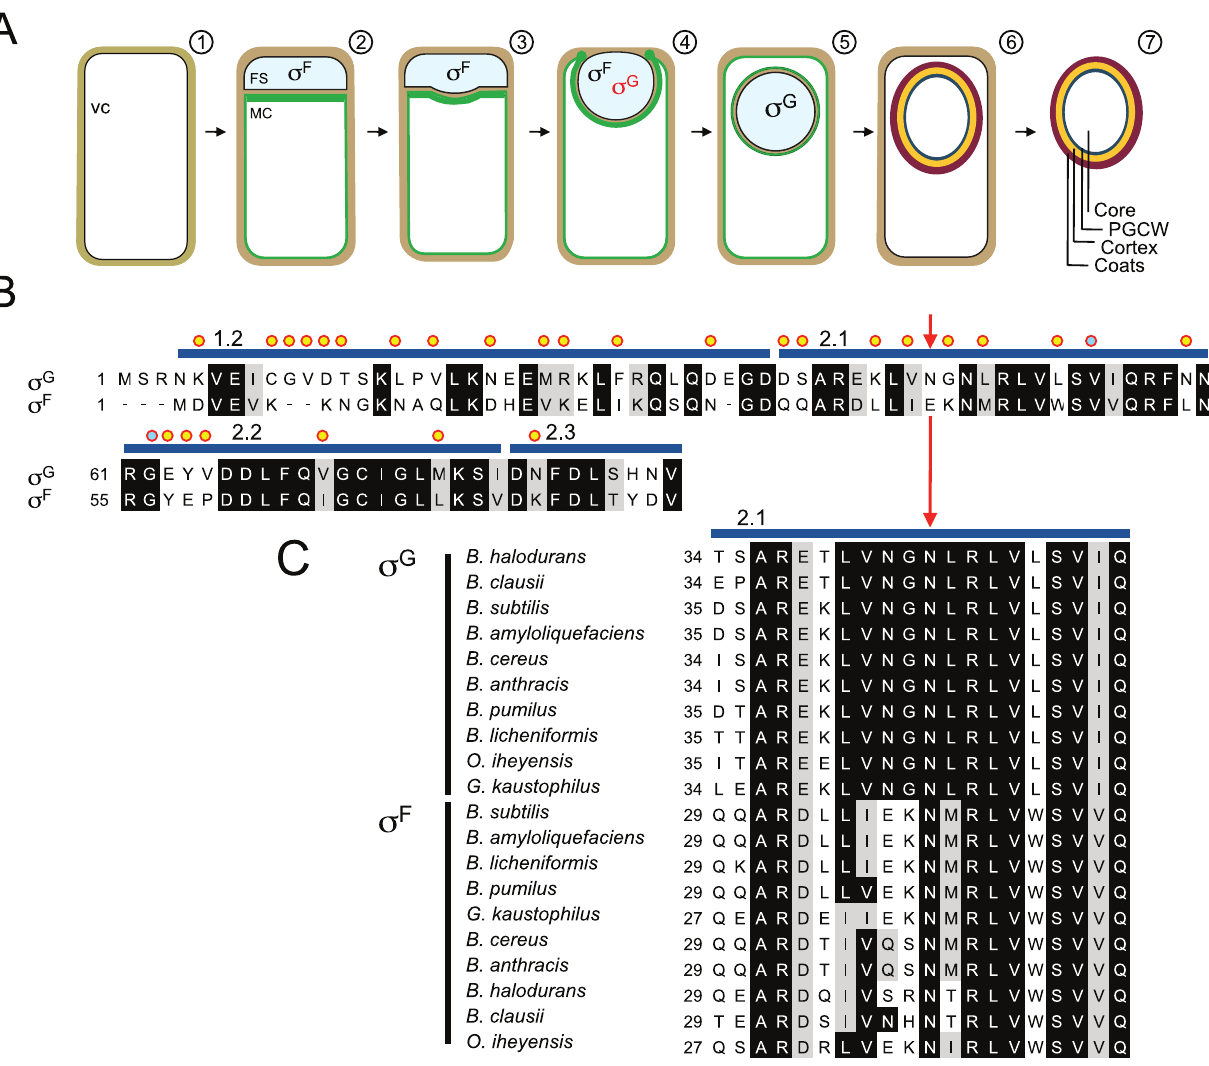
asparagine to a glutamic acid (henceforth N45E) that increased the activity of s G in vivo, as monitored using a fusion of the s G -